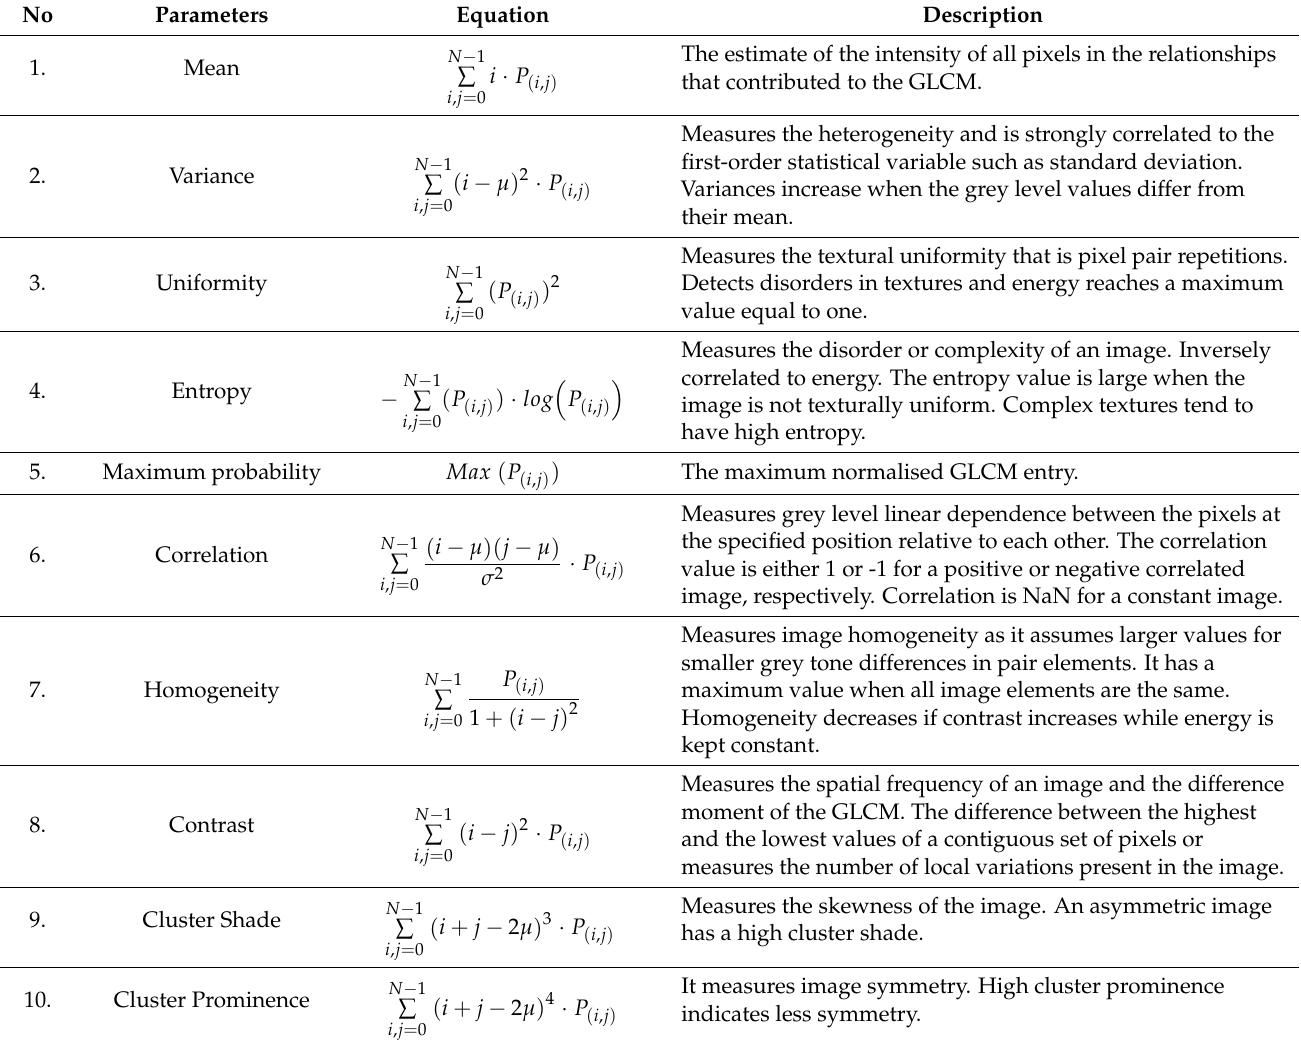
Table 2. The textural features and their